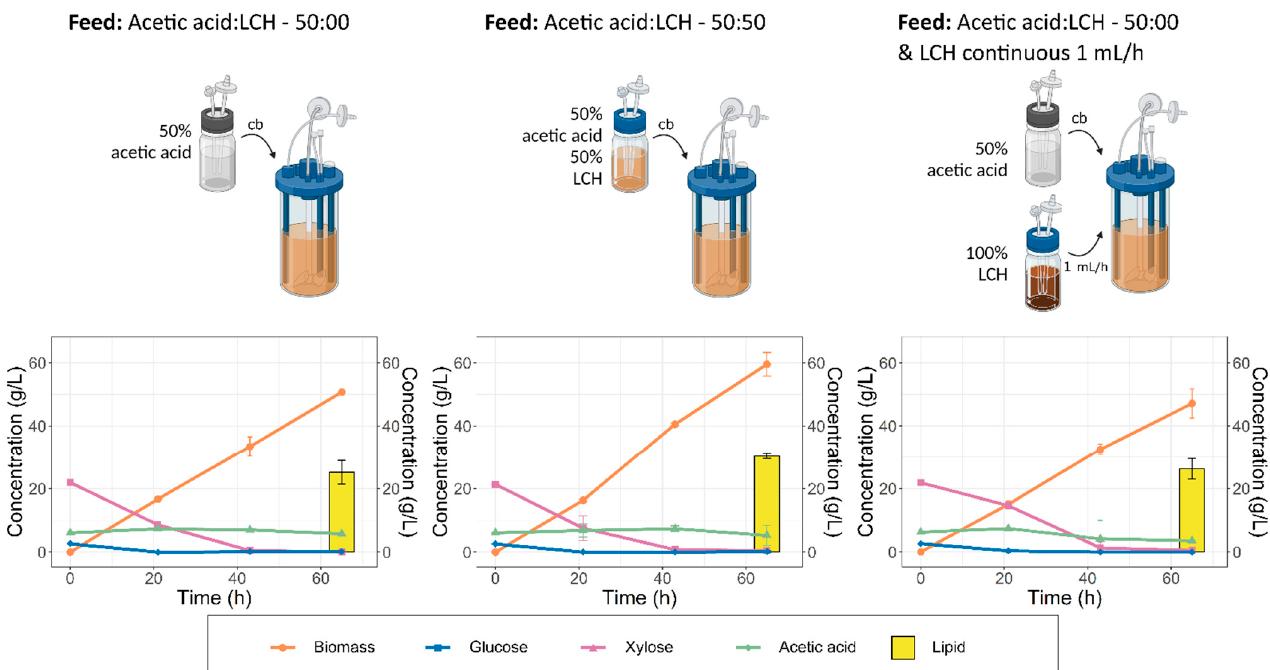
Figure 3. Comparison of the different feeding strategies in 0.25 L scale in the DASbox ® system. Below each schema, the biomass accumulation, substrate concentration, and total lipid titer after 65 h are shown. On the left side, the consumption-based acetic acid feed with a 50% acetic acid solution is displayed (acetic acid:LCH 50:00), in the middle the consumption-based feed mixture of LCH and acetic acid (acetic acid:LCH—50:50), and on the right side the combination of continuous feeding with LCH at 1 mL/h and consumption-based acetic acid feeding (acetic acid:LCH 50:00 and LCH continuous). Fermentations were performed in duplicates at least. Error bars display two times